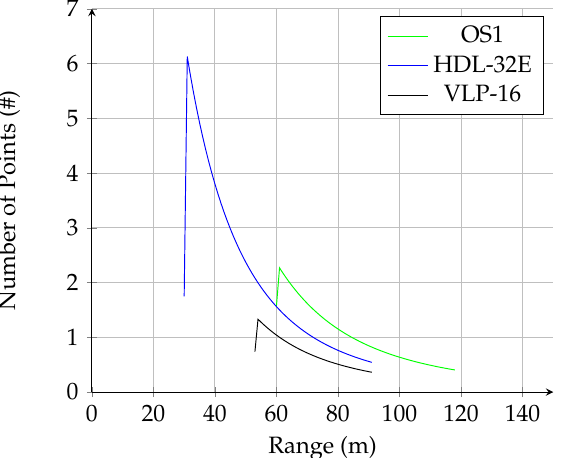
Figure 11. Predicted instantaneous number of points on negative obstacle vs. range for different